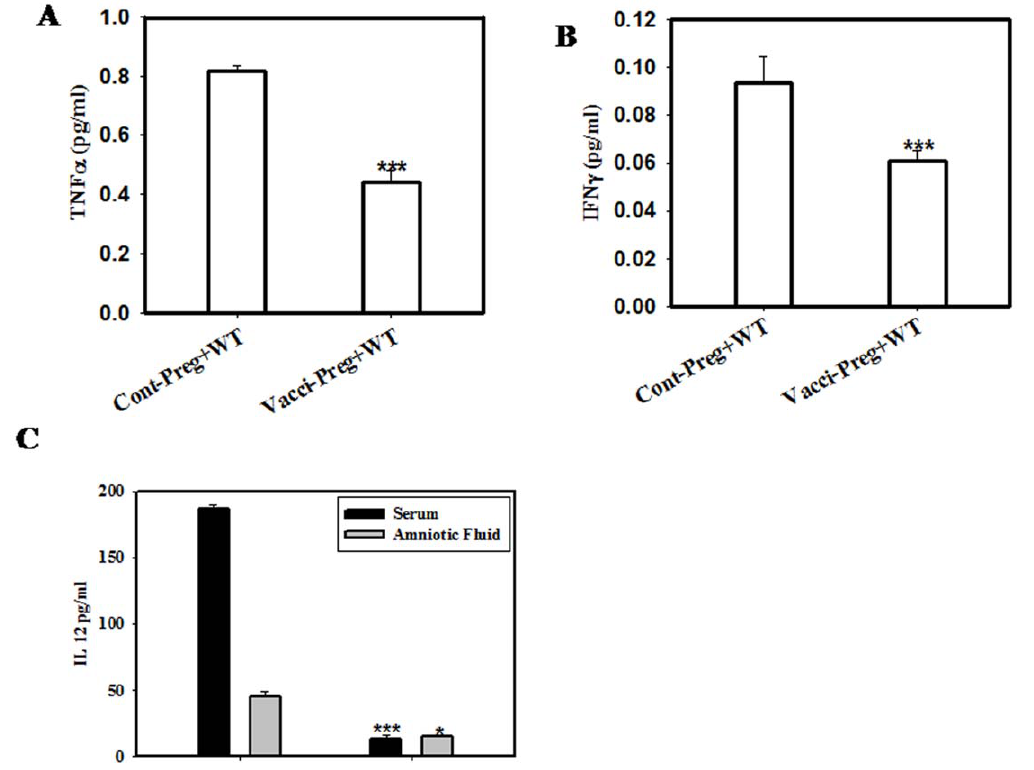
Figure 5. Th1 cytokines were significantly increased in unvaccinated mice as compared to the vaccinated pregnant mice. There is an increase in TNF a (2-fold) in amniotic fluid of unvaccinated mice (A). The serum INF c levels also increased (B). The IL-12 level in serum as well as in amniotic fluid was higher in unvaccinated group (C). * p , 0.05, *** p , 0.0001 (Student ‘‘t’’ test). doi:10.1371/journal.pone.0009139.g005 But the overall change in the Th2 cytokine in maternal serum indicates the development of a fetus protecting cytokine milieu in the amniotic fluid compartment. Th2 serum cytokine profile also was not altered in the non-pregnant mice upon vaccination (Figure 6).